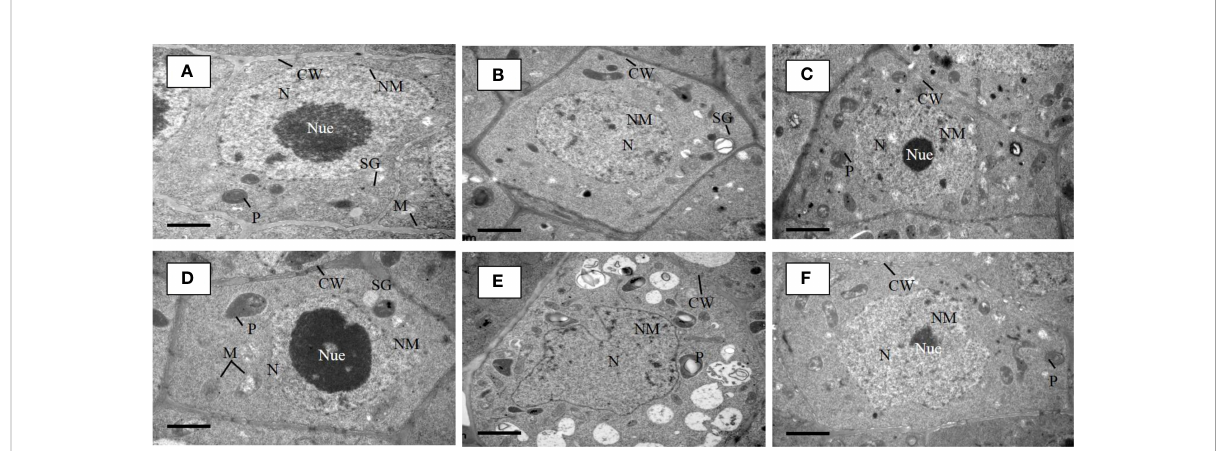
FIGURE 5 TEM micrographs of lateral root tip cells of 7-day wild-type (A) and osaux1-3 (D) mutant under control condition, 200 µM CdCl 2 (B, E) , and 200 µM CdCl 2 with B. cereus inoculated (C, F) . (A) Root tip cells of Dongjin as a wild-type cultivar and (D) osaux1-3 mutant under control (CK) show well-developed cell wall (CW), oval-shaped and clear mitochondria (M), starch grain (SG), plastids (P), nucleus (N), nuclear membrane (NM), and nucleolus (Nue). TEM micrographs of root tip cells of (B) wild-type and (E) osaux1-3 under 200 µM Cd show immature nucleus (N), plastids (P), and scattered nucleolus (Nue) and a discontinue cell wall (CW). TEM micrographs of root tip cells of (C) wild-type and (F) osaux1-3 under combined 200 µM Cd and bacterial treatment show well-developed cell wall (CW) and nucleus (N) along with a recovered nucleolus